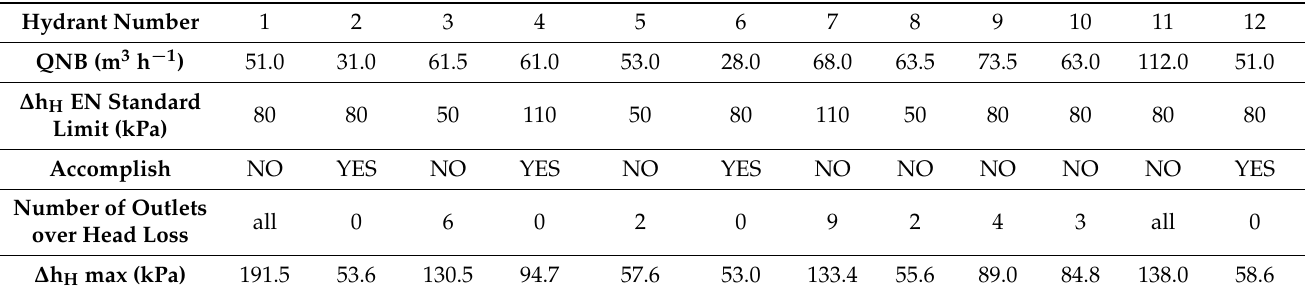
Table 4. Head loss test results.